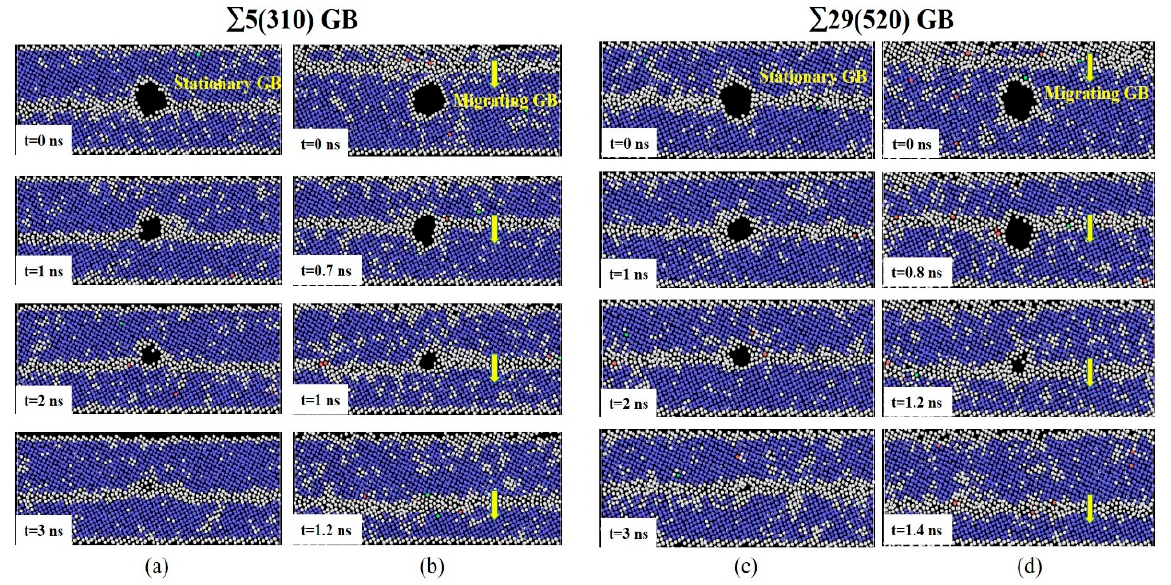
Figure 7. Cross-sectional view of the interaction between void and high-angle GBs: ( a ) stationary Σ 5(310) GB; ( b ) dynamic Σ 5(310) GB; ( c ) stationary Σ 29(520) GB; ( d ) dynamic Σ 29(520) GB.